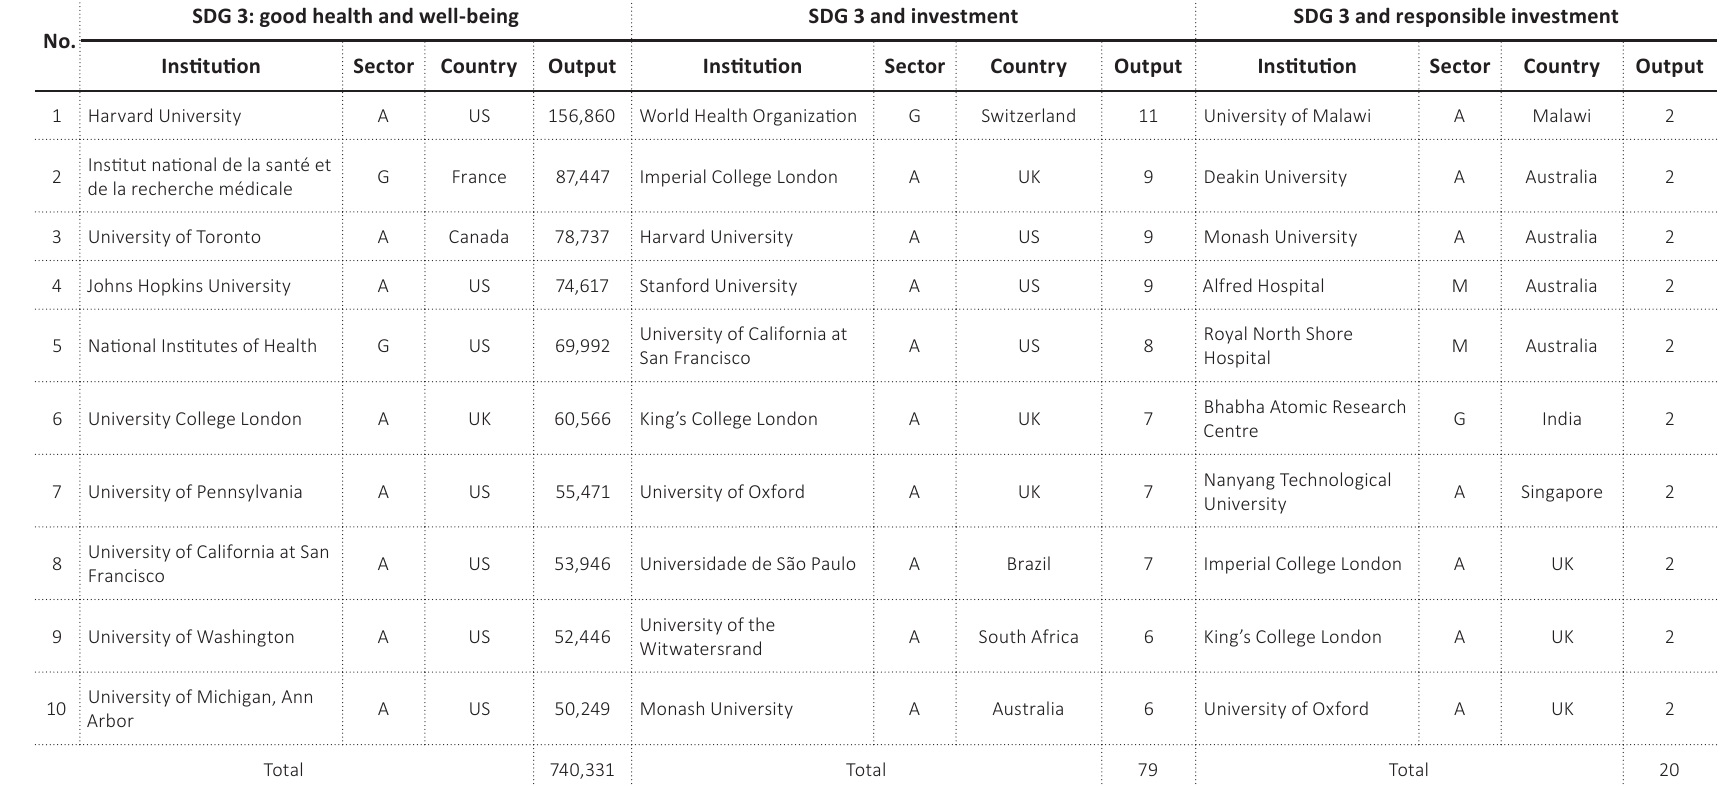
Table B1. Top 10 institutions, sectors, and countries in each research area by scholarly output, 2010–2019